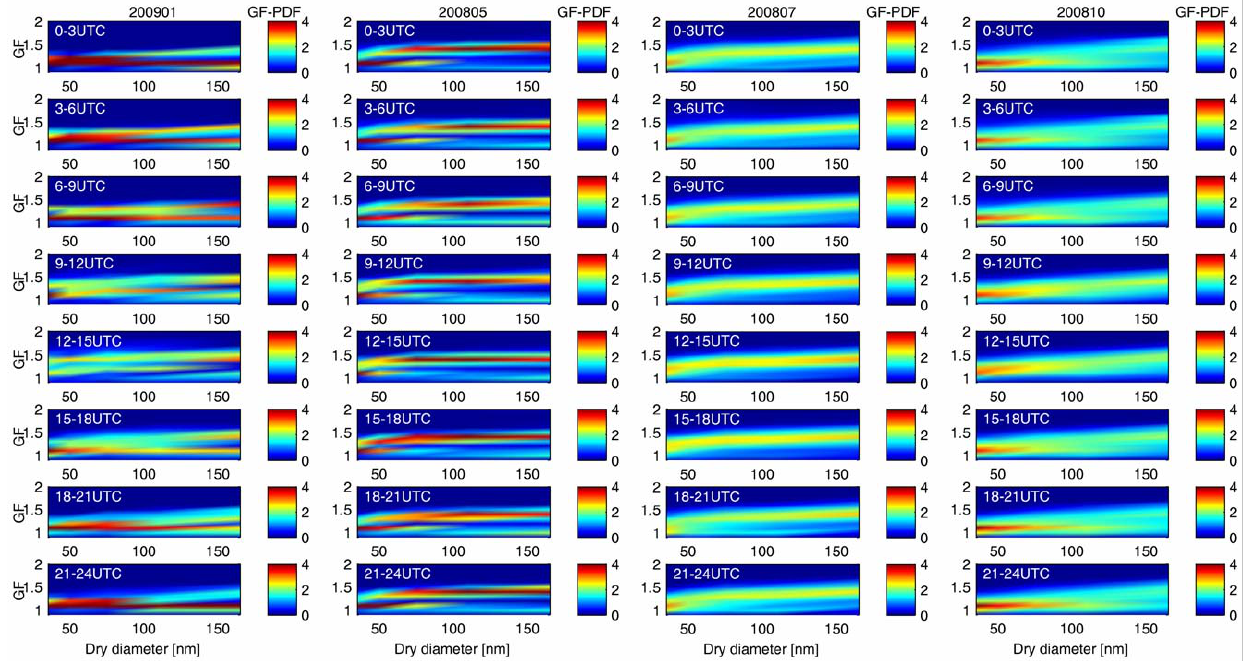
Figure 2. GF-PDF versus GF and dry diameter for January 2009, May 2008, July 2008 and October 2008.